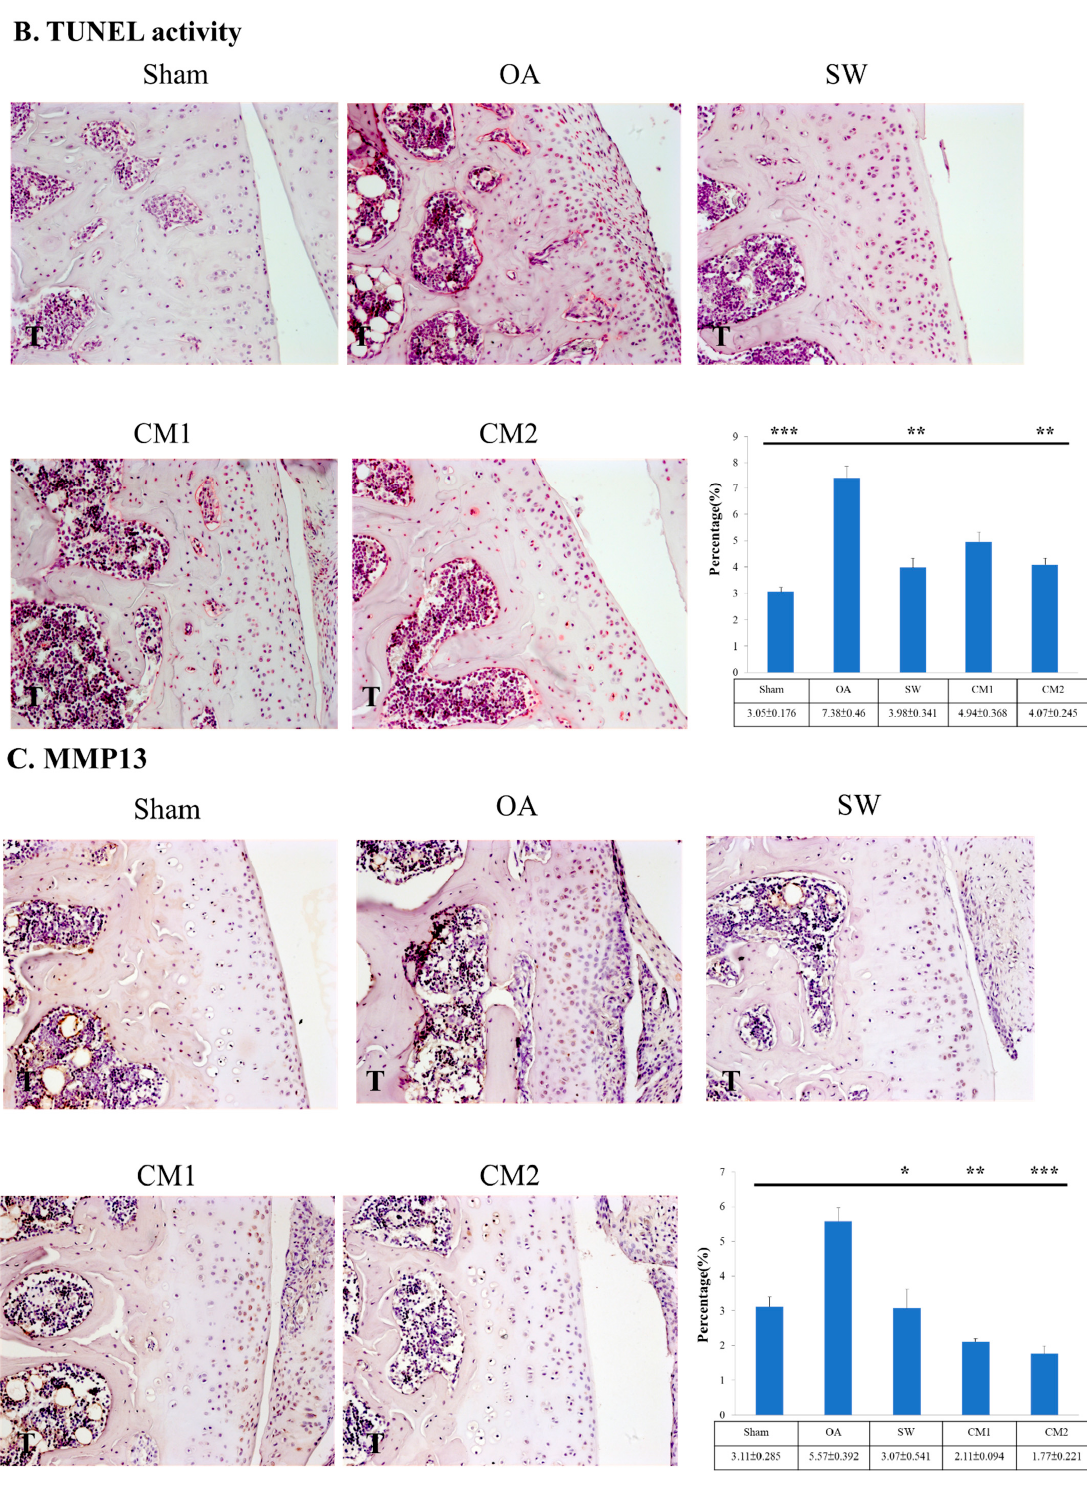
Figure 4. Apoptosis and physiological turnover of cartilage extracellular matrix factors in OA treatments. ( A ) Immunohistochemical analysis for IL1 β in the experiments (×400 magnification). The data show the percentage of IL1 β expression in the articular cartilage of the tibia for each group in the left panel. ( B ) The activity of TUNEL (×400 magnification). ( C ) The expression level of MMP13 (×400 magnification). * p < 0.05, ** p < 0.01 and *** p < 0.001 as compared with the OA group. # p < 0.05 as compared with the SW group. Eight rats were used for each group.